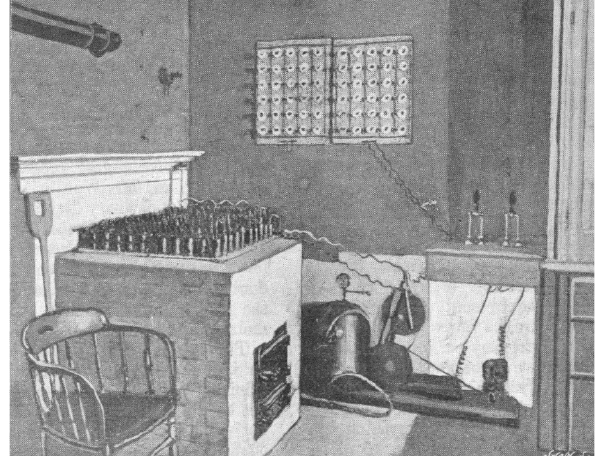
Figure 4. William Jacques’ carbon battery apparatus showing the furnace at left with carbon cells on top, and air pump at center bot- tom. Electr. Rev. (London) 1898 , 42,